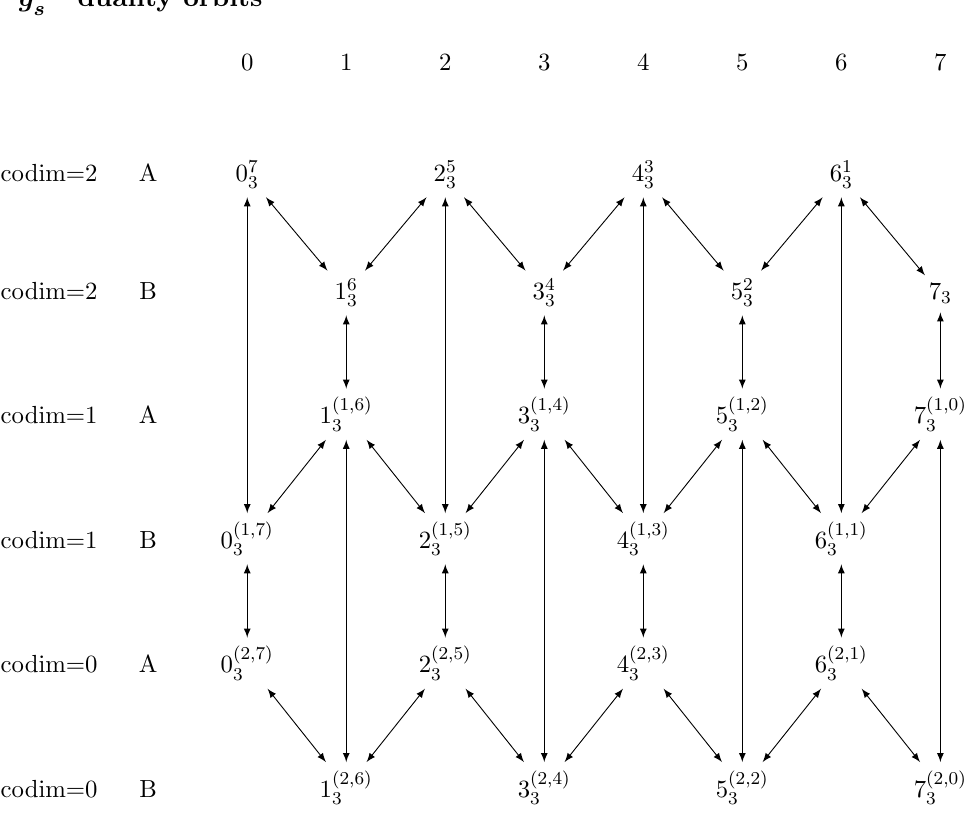
Figure 5 . The T-duality orbit of the 5 2